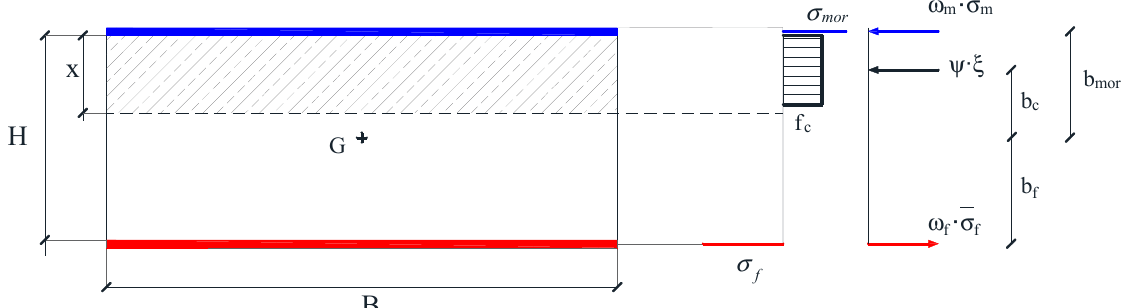
Figure 5. Equilibrium of the strengthened masonry section including the e ff ect of the mortar matrix of the composite in compression–dimensionless form.